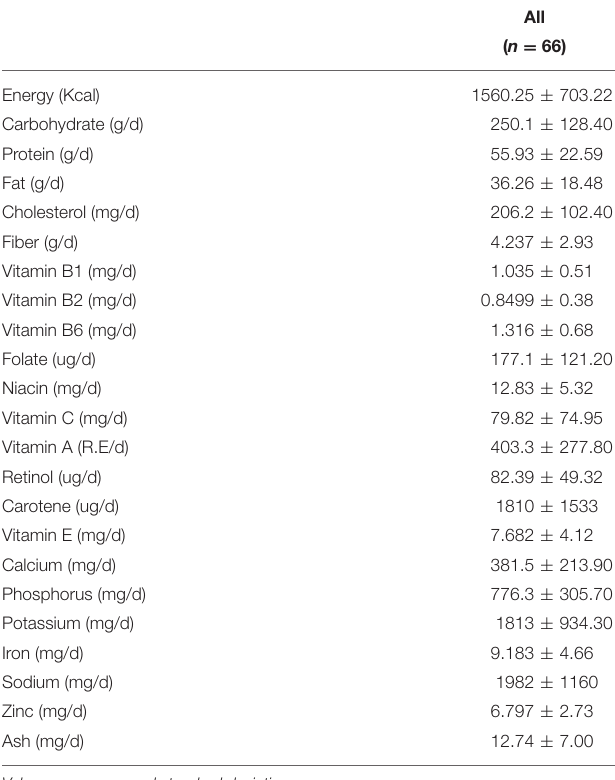
TABLE 1 | The nutrient intake (g/day) of participants at baseline.